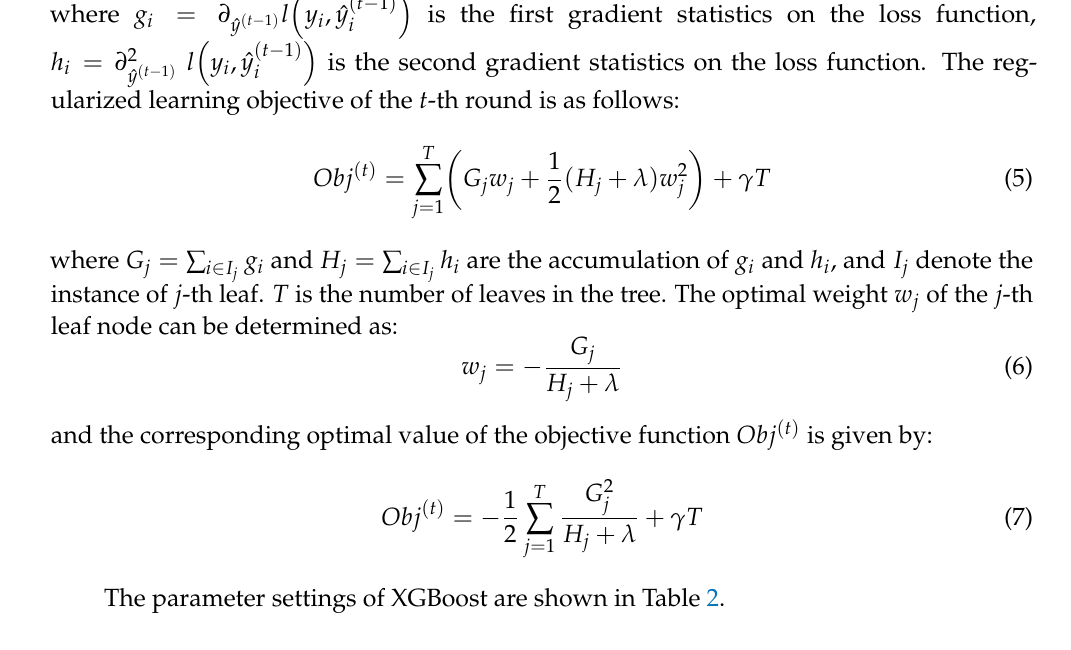
Table 2. Parameter settings of XGBoost.